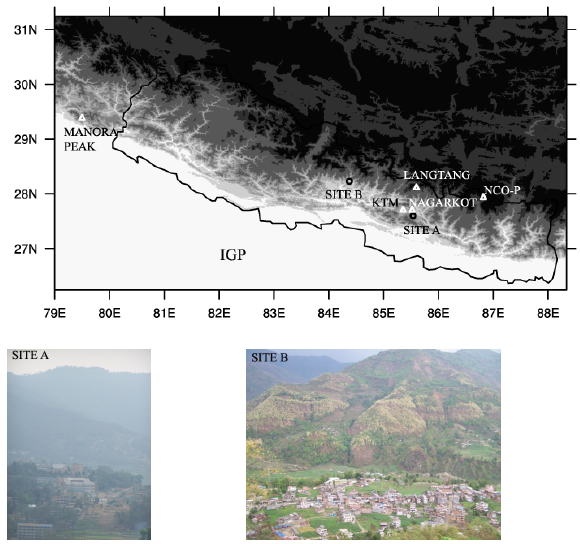
Figure 1: Sampling locations: Site A (Dhulikhel), Site B (Besisahar) and nearby locations where previous studies on aerosol physical/chemical properties were carried out. Elevation contours are plotted at following levels: 500, 1000, 1500, 2000, 4000, 5000 meters. The elevation data was downloaded from the USGS gtopo30 data. The inset pictures of Site A and Site B were taken away from the sampling location and points towards south and west direction respectively. Scattered residential area along with some agriculture fields can be seen in Site B. The Site A shows only Kathmandu University which is actually surrounded by Dhulikhel city to the east and Banepa Valley in the west, with cascades of hills to the south.